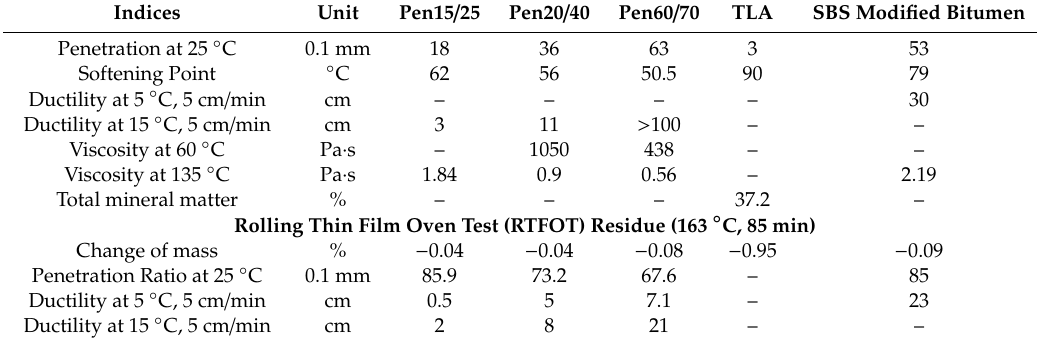
Table 1. Results of bituminous binders before blending.